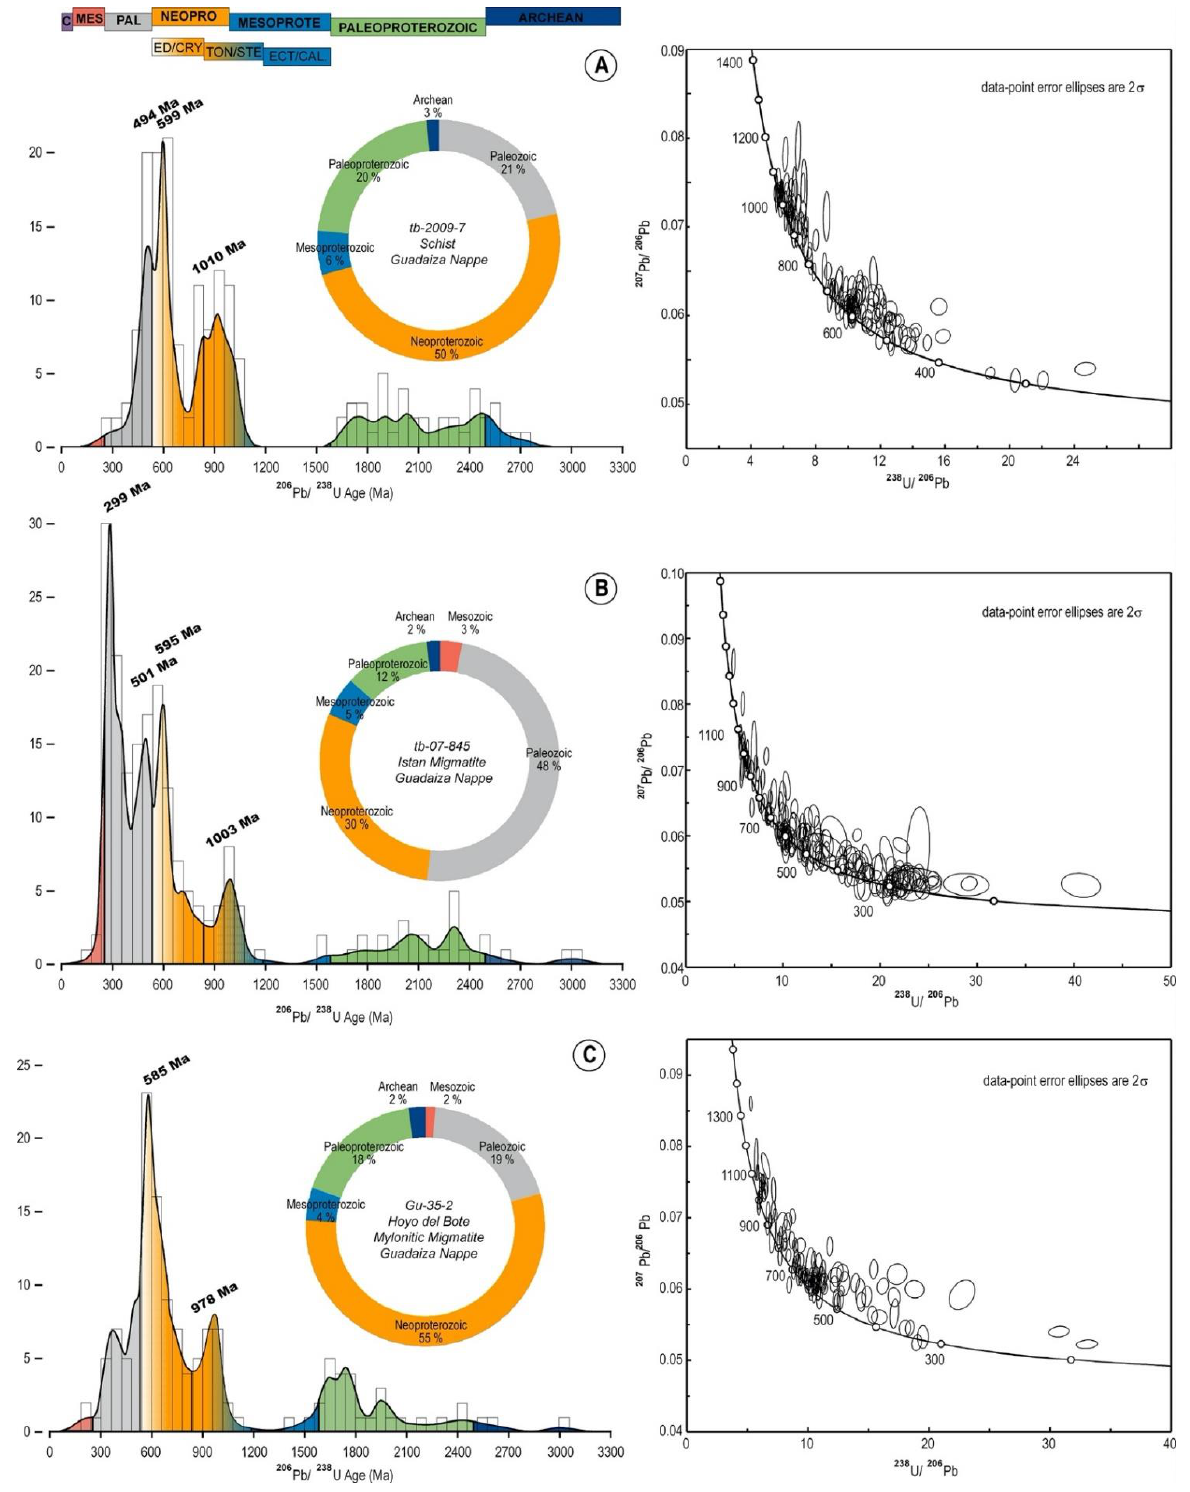
Figure 6. Tera-Wasserburg, Kernel Density Estimation (KDE) plots and histograms of age distribu- tions of analysed zircons of Guadaiza ’ s samples. ( A ) tb-2009-1, ( B ) tb-07-845 and ( C ) Gu-35-2.